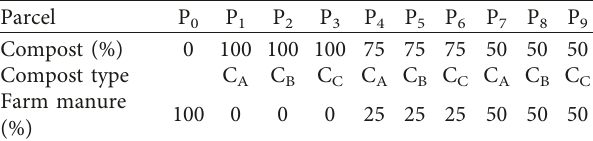
Table 3: Treatments used for parcel amendment.